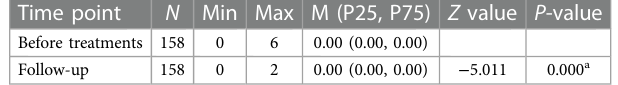
TABLE 5 Frequency of erysipelas episodes between before the treatments and during the follow-ups. Time point